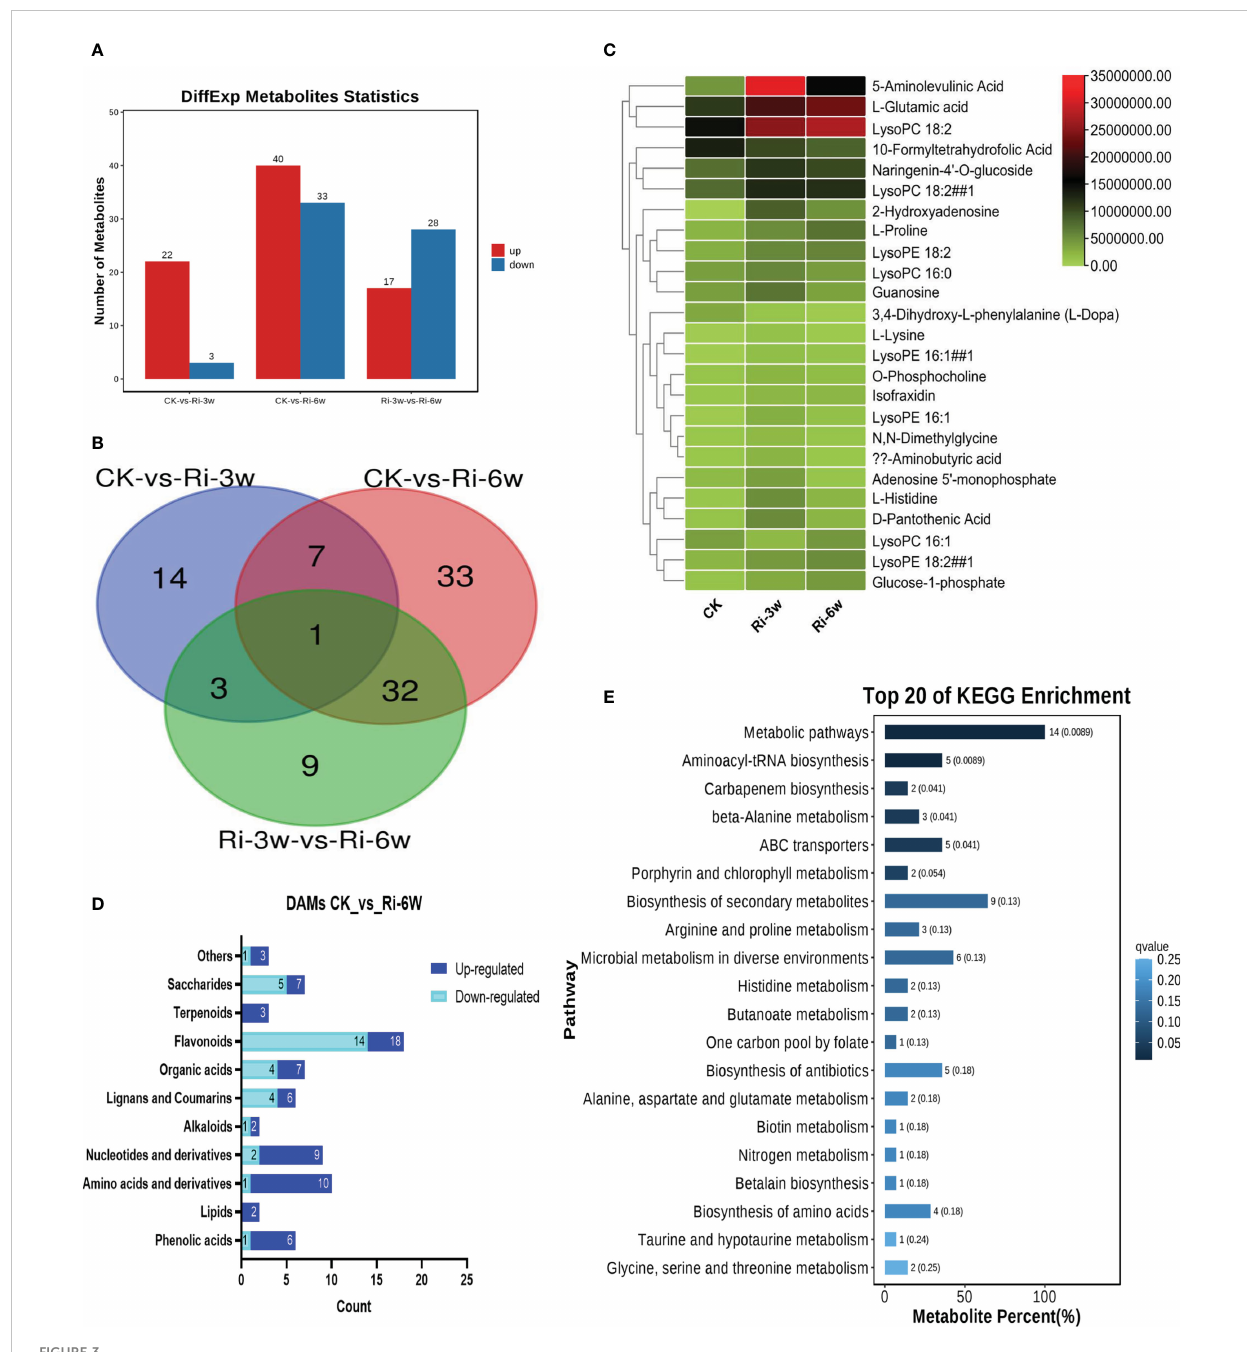
FIGURE 3 Differentially accumulated metabolites (DAMs) in pairwise comparison between groups and functional analysis. (A) Number of up- and down- regulated DAMs between groups. (B) Venn diagram showing the number of common DAMs shared by groups. (C) Heatmap of DAMs in between CK and Ri-3w. (D) Classi fi cation of DAMs between CK and Ri-6w. (E) KEGG annotation and enrichment result of DAMs between CK and